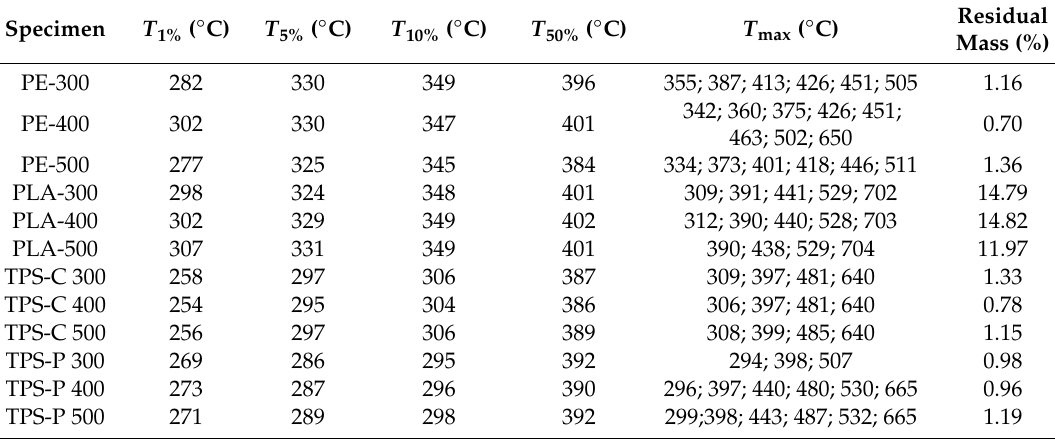
Table 5. Results obtained based on TGA curves for films.